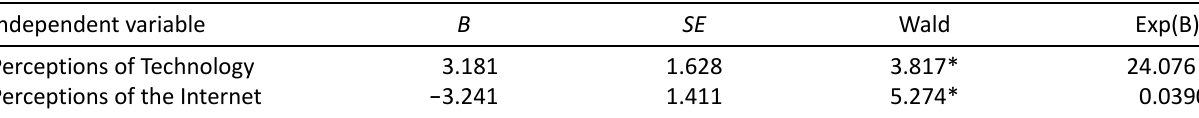
Table 3. Logistic regression results for predicting the motivation to join the course for improving computer literacy. Independent